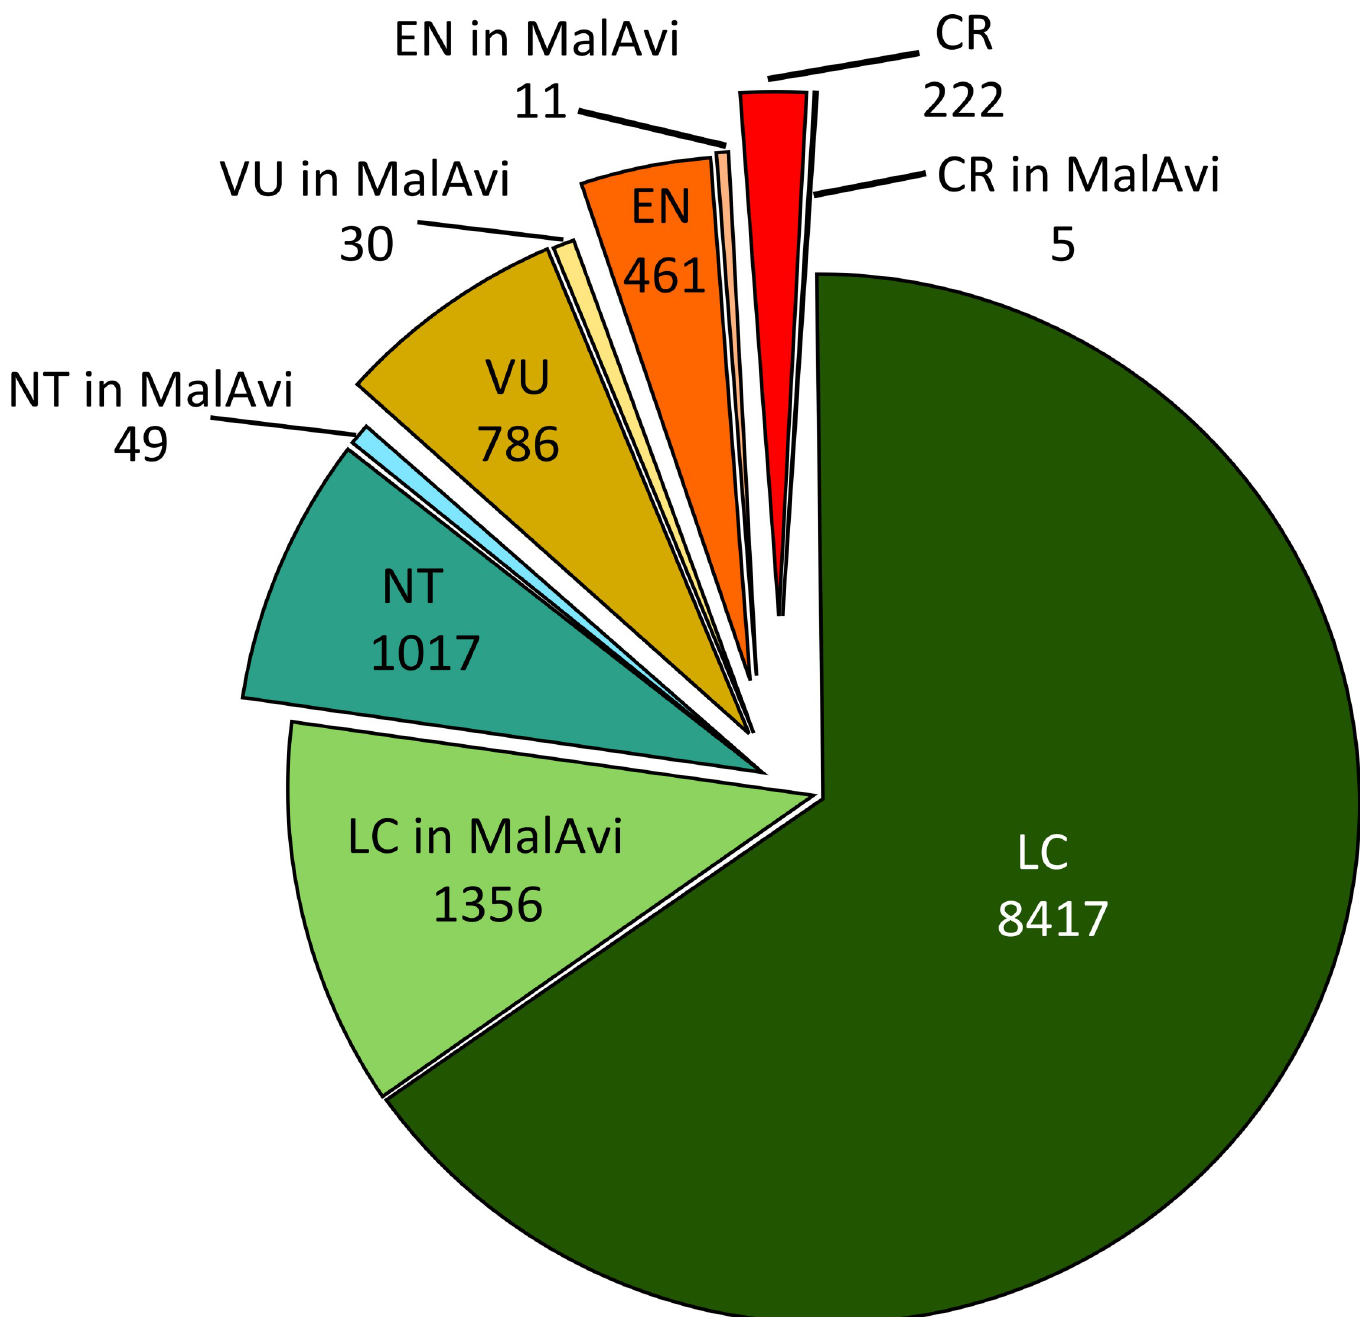
Fig 1. Number of avian species listed in each IUCN 2018 Red List Category and the subset of those that are present in MalAvi. CR, Critically Endangered; EN, Endangered, IUCN, International Union for Conservation of Nature; LC, Least Concern; NT, Near Threatened, VU, Vulnerable.